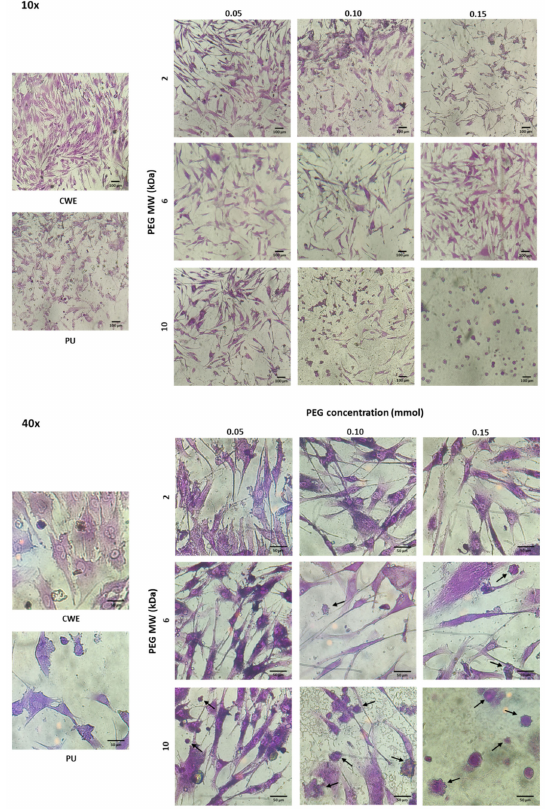
Figure 8. Microscopic images of crystal violet-stained fibroblasts in contact with extracts of the PEG-grafted PU substrata. Increasing MW and grafting densities of PEG promotes a higher num- ber of rounded cells. CWE: cells without exposition to the extracts. Arrows indicate cells with membrane